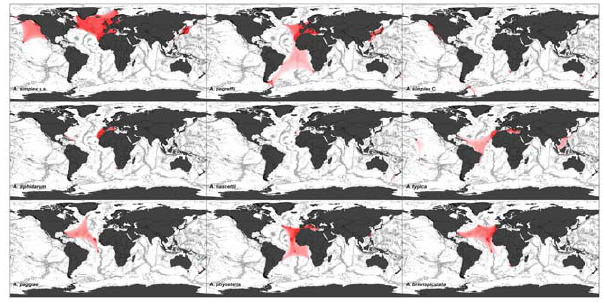
Figure 1. Modeled species range of every described Anisakis spp. Colour intensity reflects the probability of Anisakis occurrence. Dark red shadings indicate molecular proven Anisakis records. First clade: Anisakis simplex s.s., A. pegreffii , A. simplex C (building the A. simplex complex), A. ziphidarum , A. nascettii and A. typica . Second clade: Anisakis paggiae , A. physeteris and A. brevispiculata ( A. physeteris complex) belong to the second clade (phylogeny follows Klimpel et al. 2010)